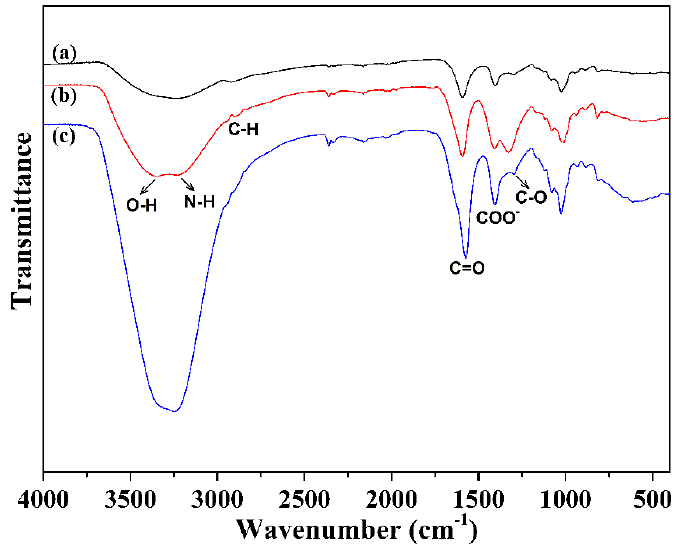
Figure 2. Infrared spectra of ( a ) raw sodium alginate, ( b ) Alg-Mel and ( c ) Alg-Mel loaded Pb 2+ .